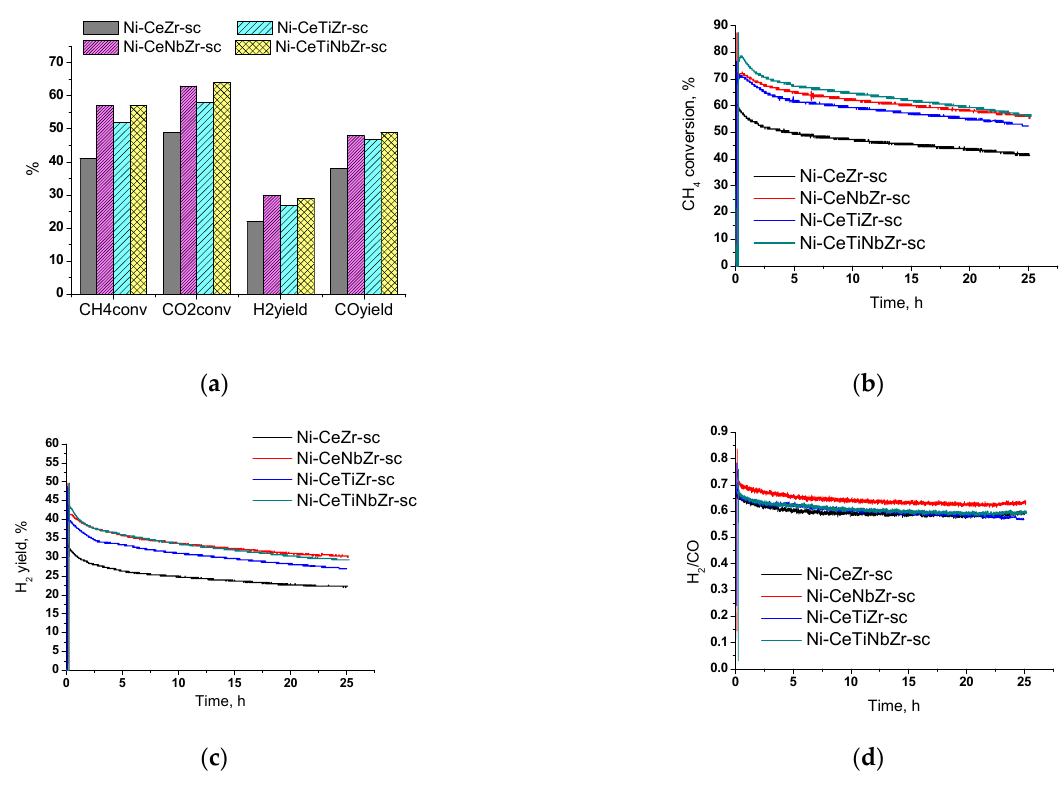
Figure 10. Results of long-term stability tests in methane dry reforming over catalysts prepared by supercritical synthesis: ( a ) values after 25 h of testing, ( b ) methane conversion, ( c ) H 2 yield, and ( d ) H 2 /CO ratio during testing for 25 h. Reaction feed 15%CH 4 + 15%CO 2 + Ar balance. Catalysts doped with both titanium and niobium showed higher activity compared with the unmodified sample. Methane conversion increases in the row Ni-CeZr-sc < Ni-CeTiZr-sc < Ni-CeNbZr-sc = Ni-CeTiNbZr-sc.